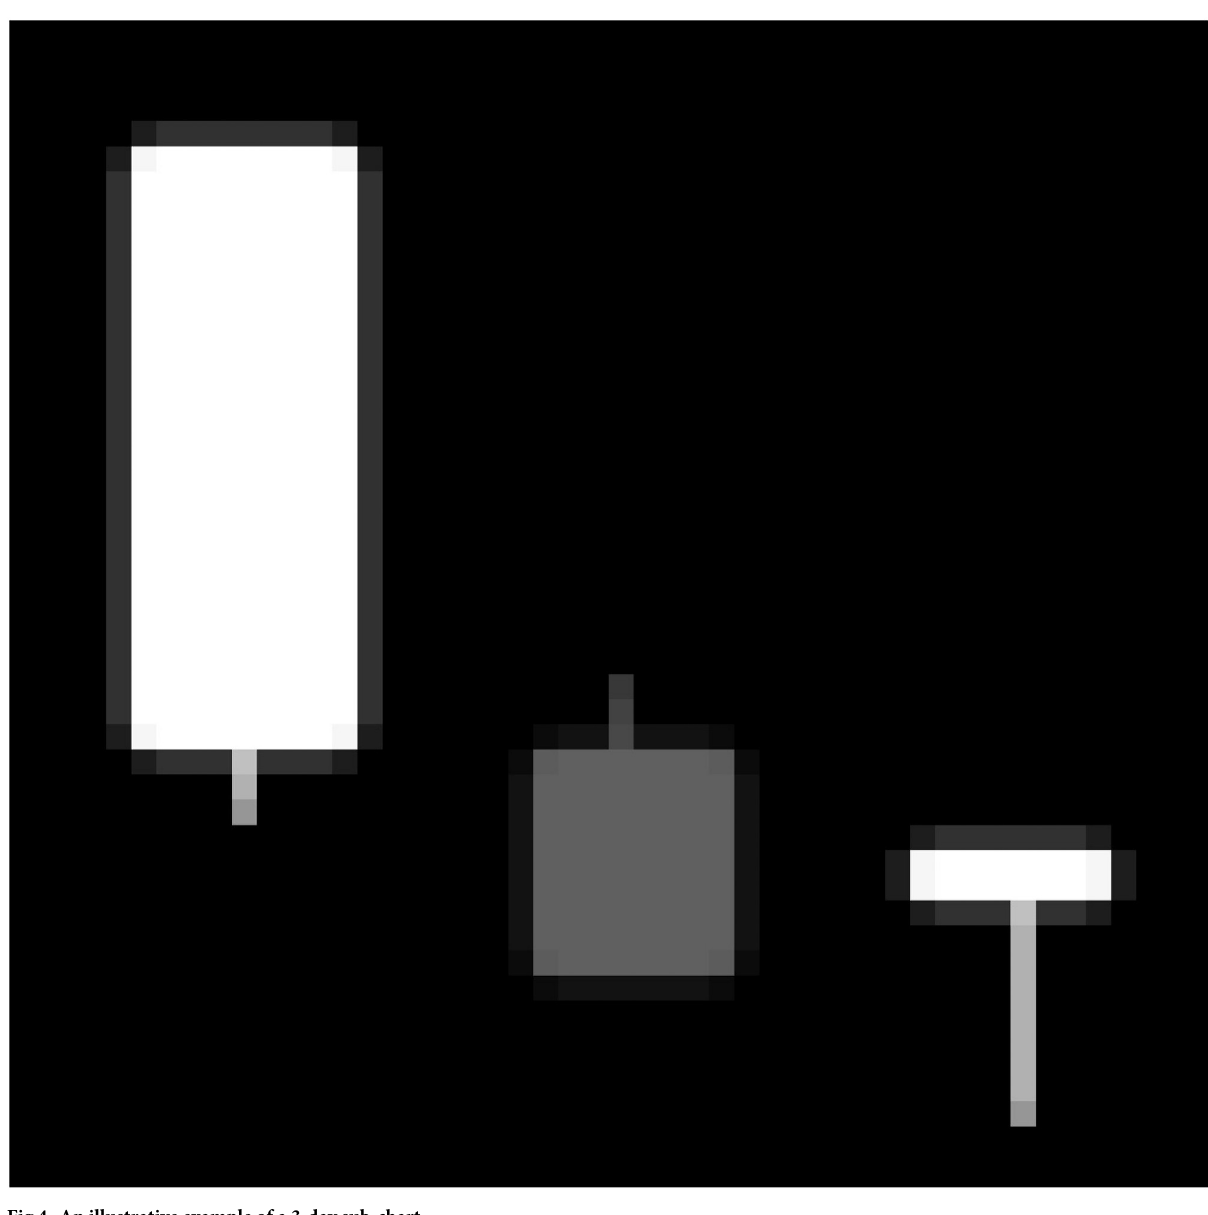
The structure and corresponding parameters of the CAE in the study are illustrated in Fig 5. First, the input dimension of CAE is 48 × 48 × 1 because of the use of a 48 pixels gray- scaled image of 3-day sub-chart. Second, there are 3 components in the encoding process: a 2D convolution layer (Conv-2D), a 2D max pooling layer (MaxPooling-2D) with ReLu as its activation function, and the parameters of each convolution layer are appeared in its bottom. Third, as the network becomes deeper, the number of channels for the conventional CNN increases and its dimension of intermediate images diminishes. Fourth, the deep feature could be achieved to have the dimension of 3 × 3 × 64 via the average pooling in the 8th layer. The